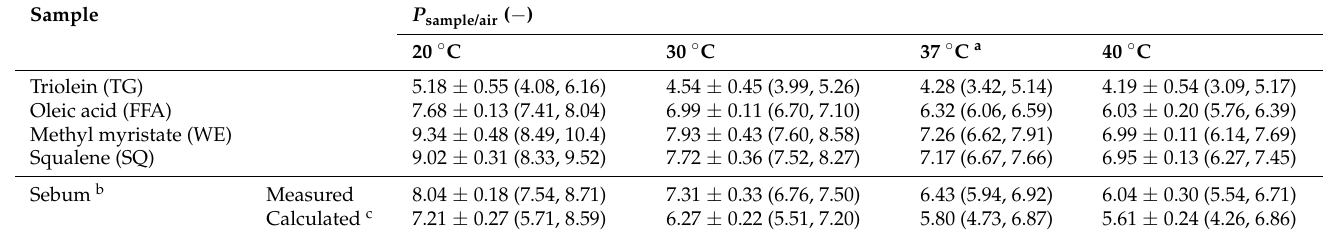
Table 2. Measured partition coefficients of radon for sebaceous lipid